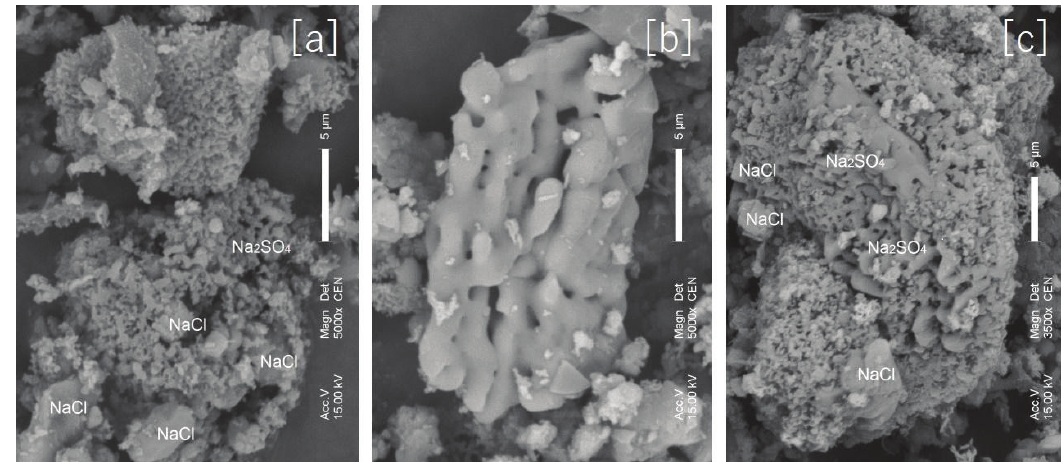
CO grain with embedded small parti- 2 3 SO and NaCl 2 4